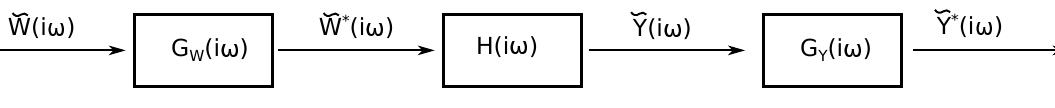
Figure 8. Block diagram of the transfer functions for a general FRA